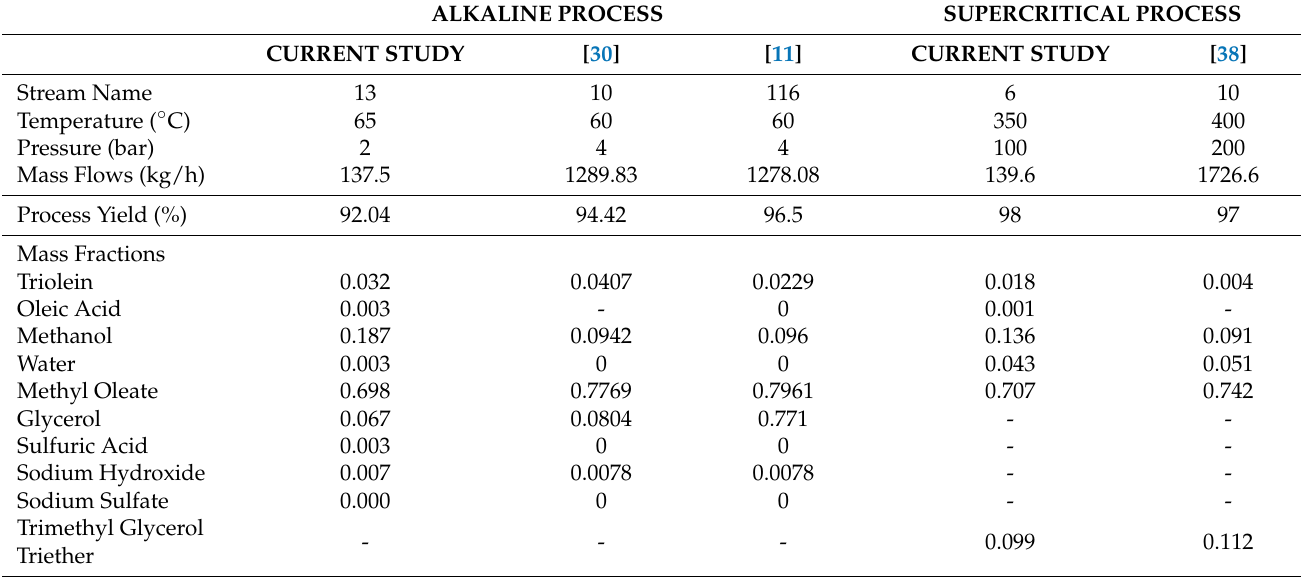
Table 4. Validation of the outflow stream of transesterification